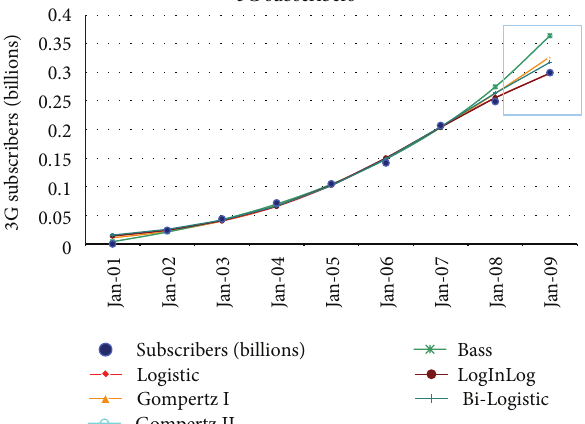
Figure 27: Residuals of the modified-hGP model in forecasting (2 years window period) of the number of OECD mobile prepay subscribers.